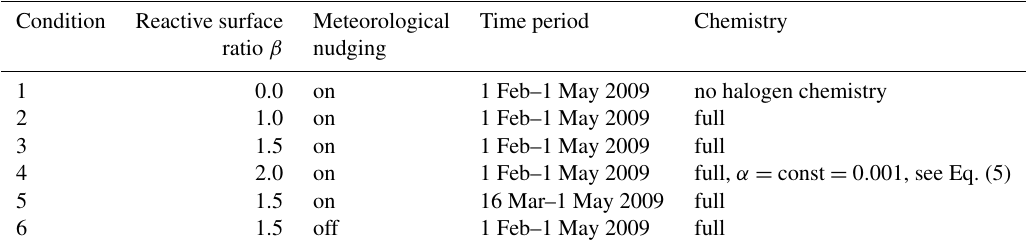
Table 2. Parameter variation in the